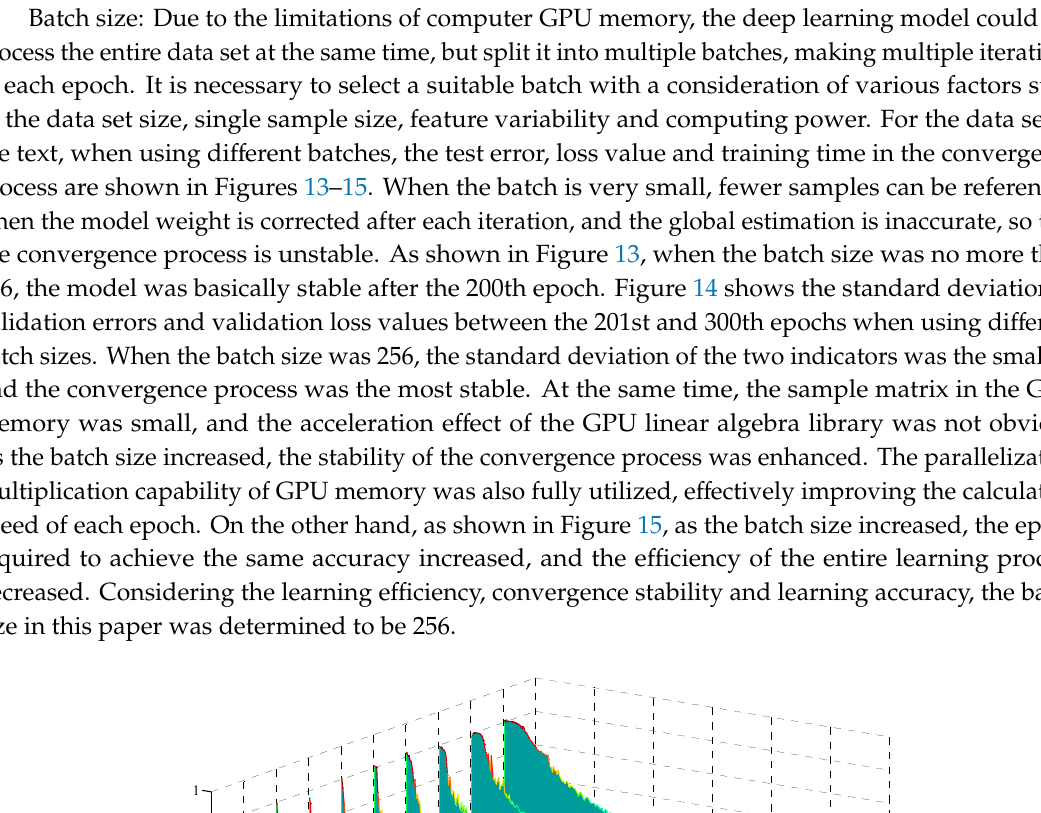
Figure 14. The standard deviation of the validation error and validation loss value after the model was stabilized. Figure 15. The effect of batch size on the calculation time cost of a single epoch and the speed of model learning. Learning rate: The error and the learning rate together determine the adjustment of the model weight after each iteration. An ideal learning process is that the convergence curve of loss values falls smoothly and eventually converges to a small residual error. There is an optimal learning rate for a specific task and data set. The higher learning rate allows the model to be quickly adjusted.